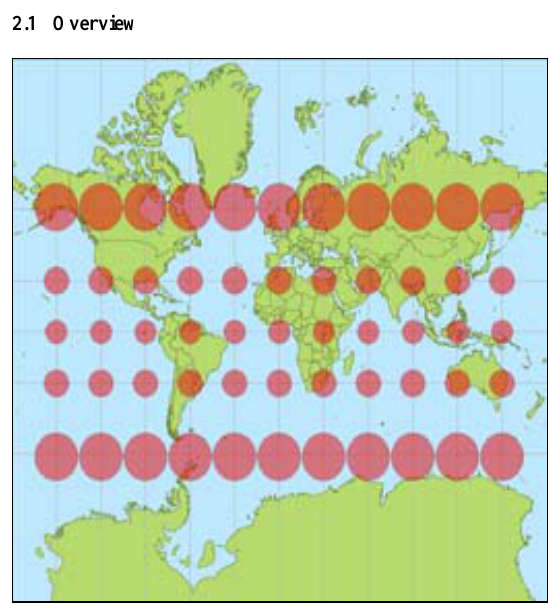
Figure 1: A conformal projection (Mercator, equatorial aspect) with exaggerated Tissot circles. (Source: Stefan Kuhn,